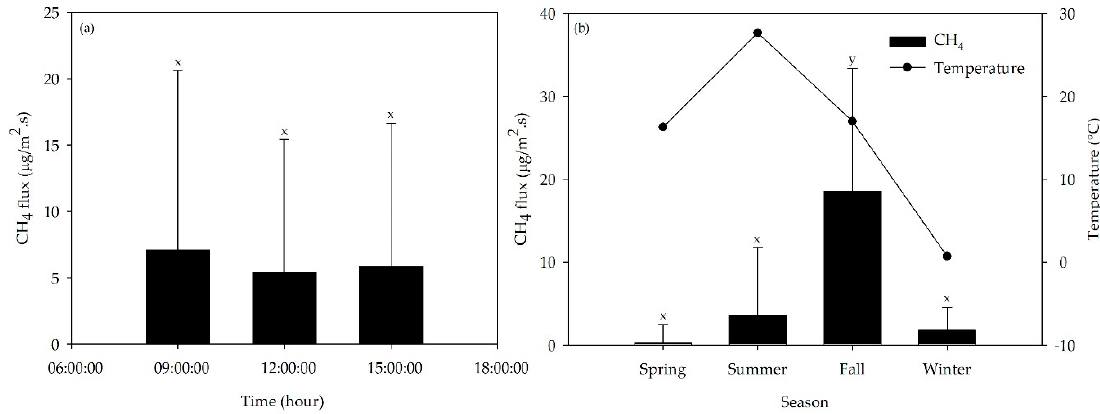
Figure 5. Average CH 4 flux from litter by ( a ) time and ( b ) season (error bars represent the standard deviation of the average). Flux means with the same letter are not significantly different ( p > 0.05) .